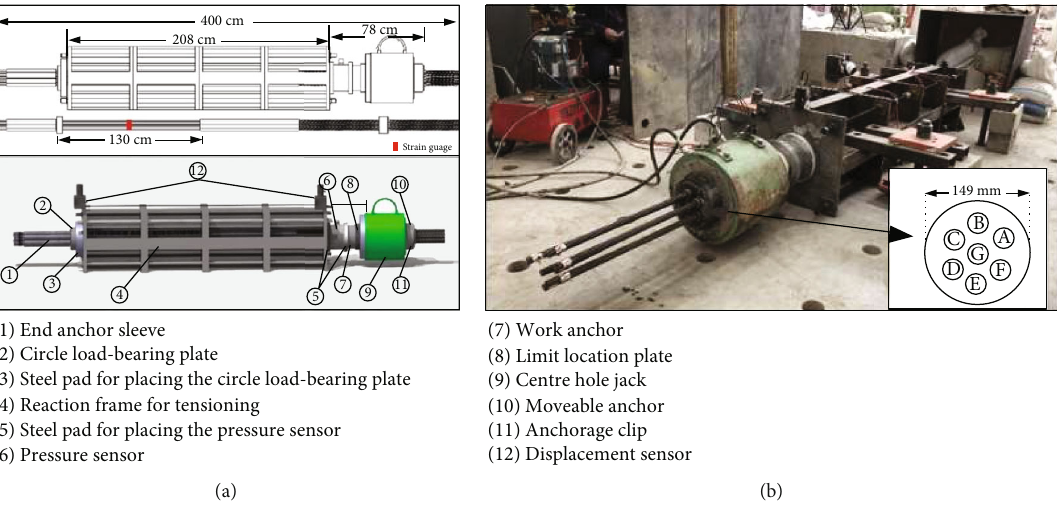
Figure 5: The tensile strength test of this BFRP cable anchor: (a) the schematic of the tensioning operation and (b) the indoor tensioning operation where seven bunches of the “ BFRP-connector-strand ” were numbered with A , B , C , D , E , F , and G